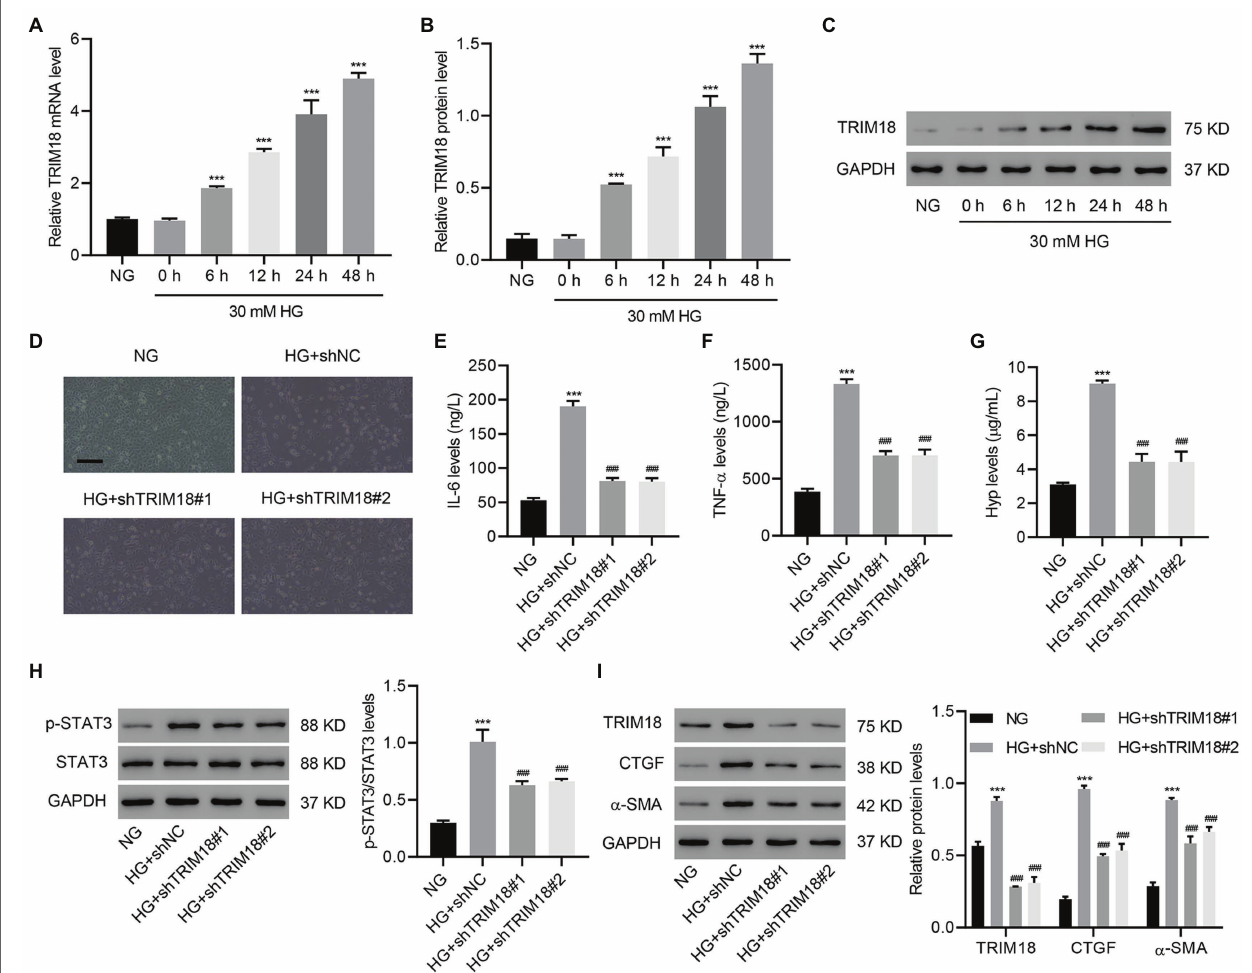
FIGURE 3 | TRIM18 knockdown inhibits HG-induced epithelial–mesenchymal transition (EMT), inflammation, and fibrosis. (A–C) TRIM18 expression in HG-treated HK-2 cells. TRIM18-silenced HK-2 cells were treated with HG, and then the (D) cell morphology, (E–G) levels of IL-6, TNF- α , and Hyp, and (H,I) expression of p-STAT3, TRIM18, CTGF, and α -SMA were measured. Scale bar: 100 μ m. Values are presented as mean ± SD. n = 3/group. *** p < 0.001 vs. NG. ### p < 0.001 vs.